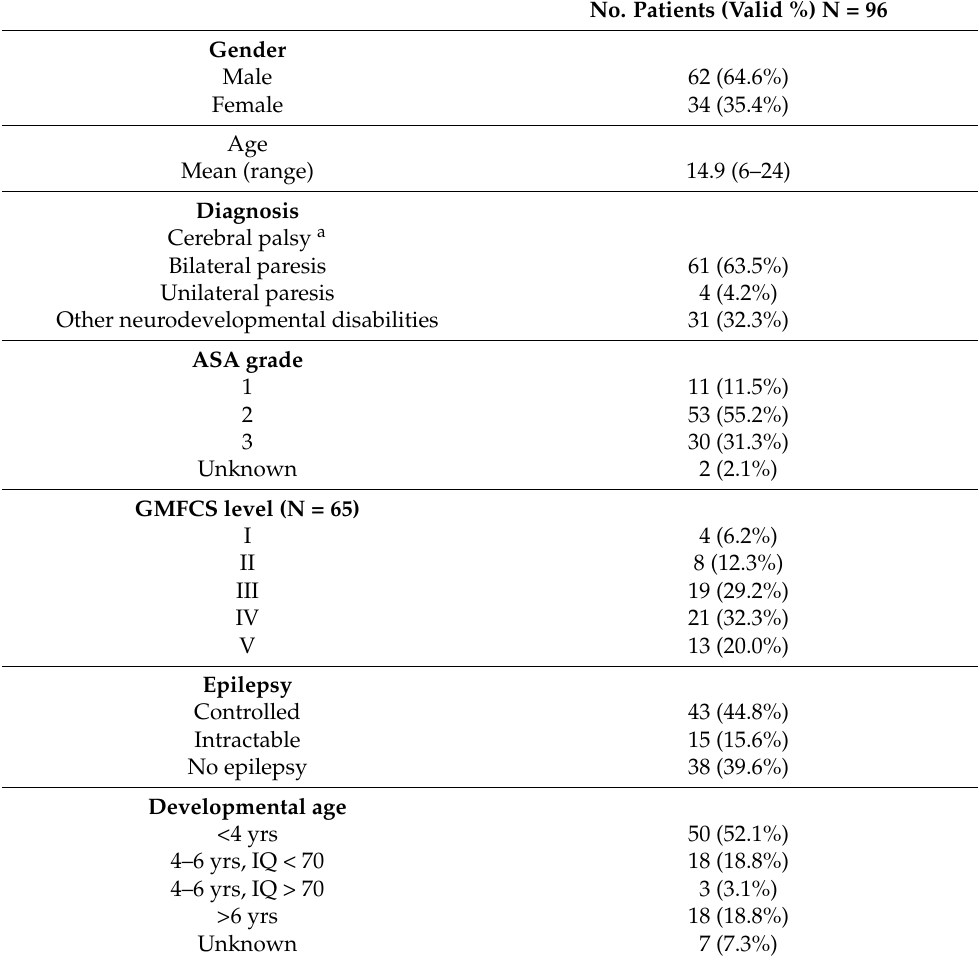
Table 1. Demographic